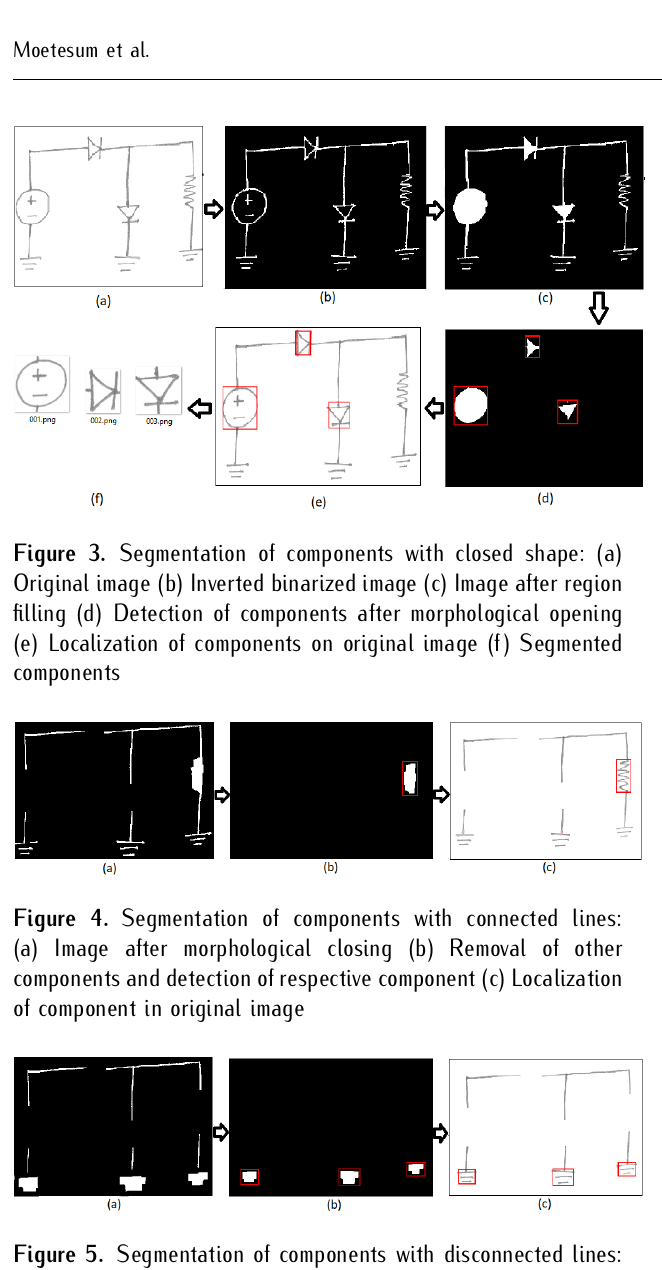
Figure 5. Segmentation of components with disconnected lines: (a) Image after morphological thickening and thinning (b) Removal of other components and detection of respective components (c) Localization of components in original image